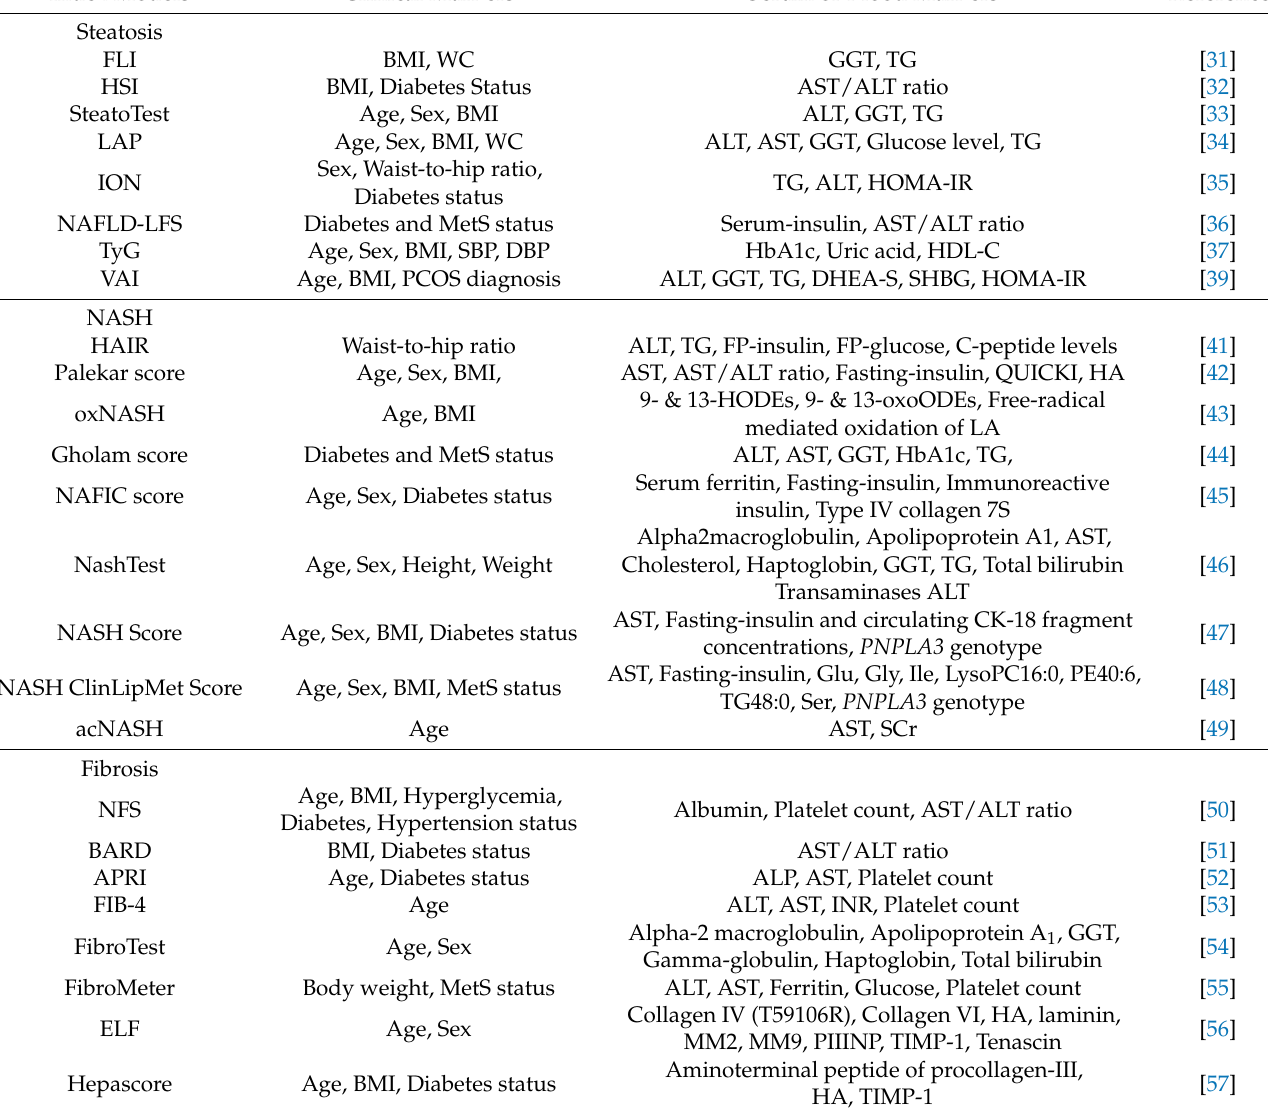
Table 1. Summary of the serum or plasma biomarker indexes used to diagnose